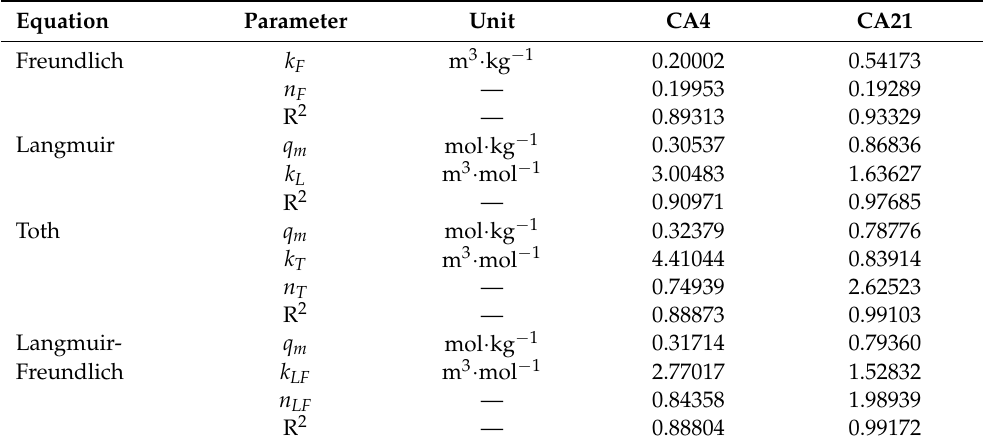
Table 3. Adsorption isotherm parameters for Ru(cod)(tmhd) 2 from scCO 2 solution at 27.6 MPa and 353 K on different substrates [53].